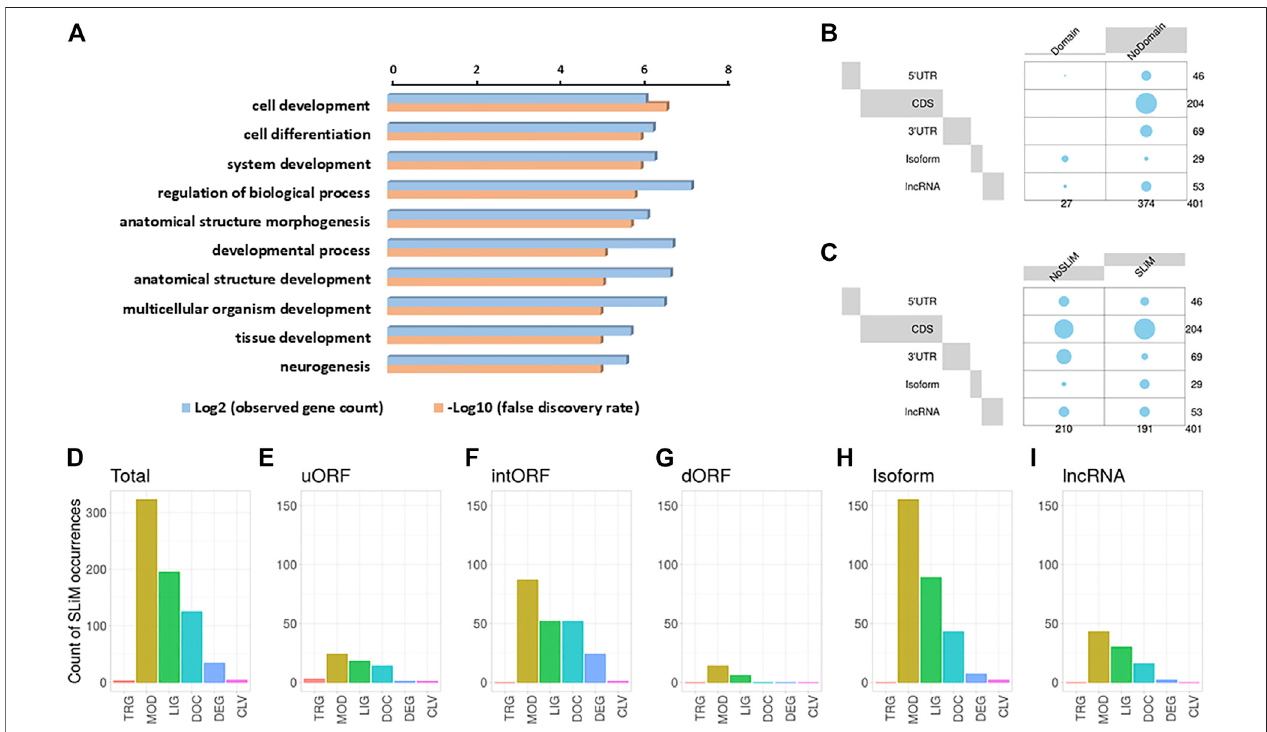
FIGURE 4 | Identi fi cation of protein domains and short linear motifs in alternative proteins. (A) . Gene Ontology term analysis of the host genes of the alternative proteins identi fi ed. (B) . Balloon plots showing the presence or lack of protein domain for the different types of ORFs, from which the AltProts are produced. The area is proportionaltothefrequency. (C) .BalloonplotsshowingthepresenceorlackofSLiMsforthedifferenttypesofORFs,fromwhichtheAltProtsareproduced.Theareais proportionaltothefrequency.D-I.CountsofthedifferentclassesofSLiMsintheAltProtsidenti fi edinthisstudy (D) oridenti fi edfromuORFs (E) ,intORFs (F) ,dORFs (G) , isoforms (H), or lncRNA (I) . SLiM classes are targeting sites for subcellular localization (TRG), post-translational modi fi cation sites (MOD), ligand binding sites (LIG), docking sites (DOC), degradation sites (DEG), and proteolytic cleavage sites